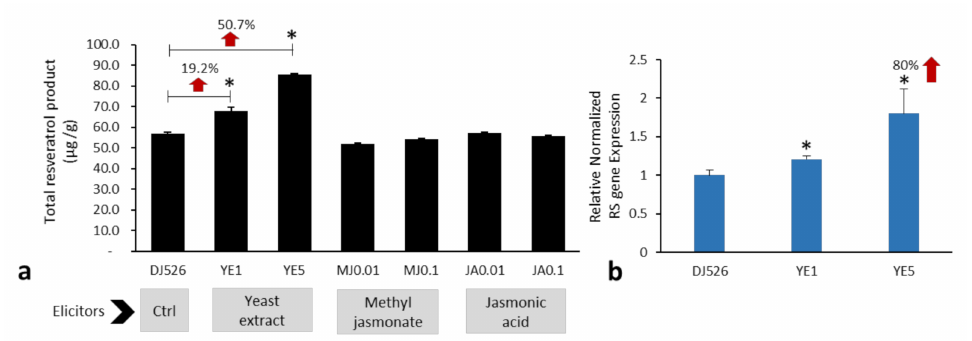
Figure 1. Resveratrol bioproduct and RS gene expression in elicitor-treated DJ526 seeds, including 1 and 5 g/L yeast extract (YE1, YE5), 0.01 and 0.1 mM methyl jasmonate (MJ0.01, MJ0.1), and 0.01 and 0.1 mM jasmonic acid (JA0.01, JA0.1). ( a ) Among various elicitors, YE1 and YE5 elevated resveratrol product levels to >19% and 50% that of the non-elicitation DJ526 seeds (Ctrl). ( b ) YE5 upregulated RS gene by approximately 80% that of the control (DJ526). * p < 0.05 compared with the control. Table 1. Antioxidant activity of DJ526 and elicitor-treated DJ526 seed extracts at various concentra- tions (1–100